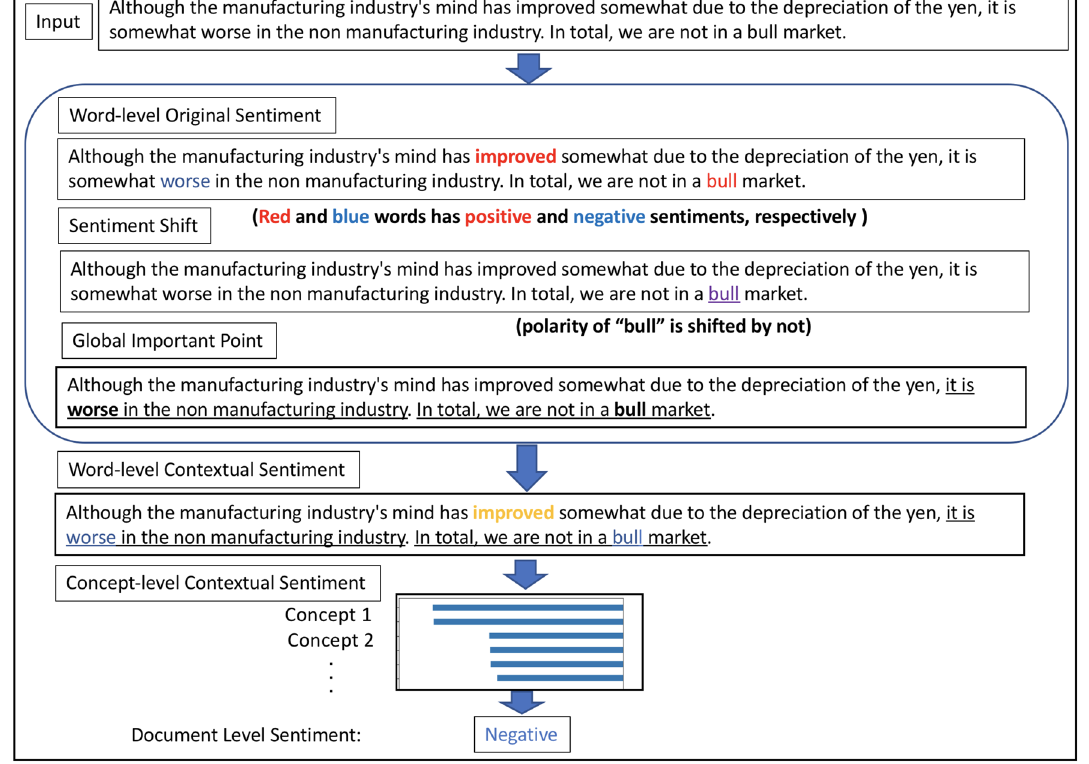
Fig. 1 Goal: development of neural network (NN) that can explain its prediction results using four types of